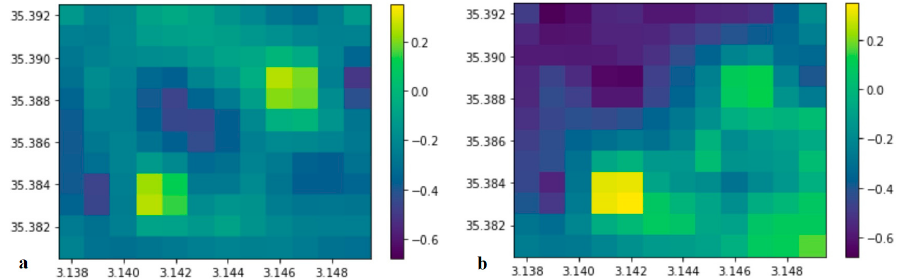
Figure 7. ( a ) Colored map to evidence differences between magnetic and the C Rn values; ( b ) similarly for the gravity and the C Rn values. The map abscissa is the latitude, and the ordinate is the longitude. Numbers near the column indicate the degree of similarity (lowest: 0.4; highest: −